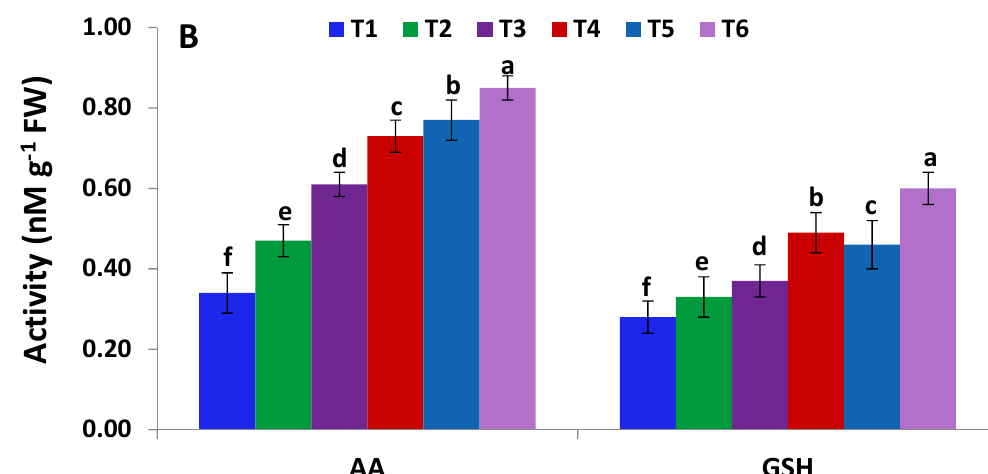
Figure 1. Levels of enzymatic ( A ) and non-enzymatic ( B ) antioxidants in maize plants in the absence and presence of Serratia liquefaciens KM4 under different saline concentrations. Data are means ± SE ( n = 5). Different letters indicate significant differences among treatments. T1, non-inoculated control plants; T2, Serratia liquefaciens KM4-inoculated plants; T3, 80 mM NaCl-treated plants; T4, plants primed with 80 mM NaCl and Serratia liquefaciens KM4; T5, 160 mM NaCl-treated plants; T6, plants primed with 160 mM NaCl and Serratia liquefaciens KM4.